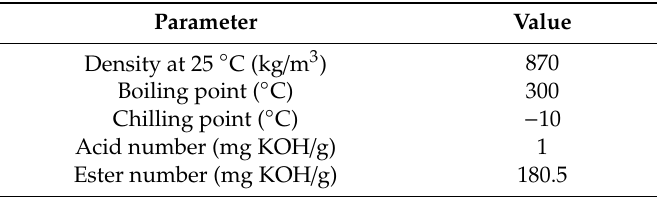
Table 2. Fatty acid methyl ester of rapeseed oil